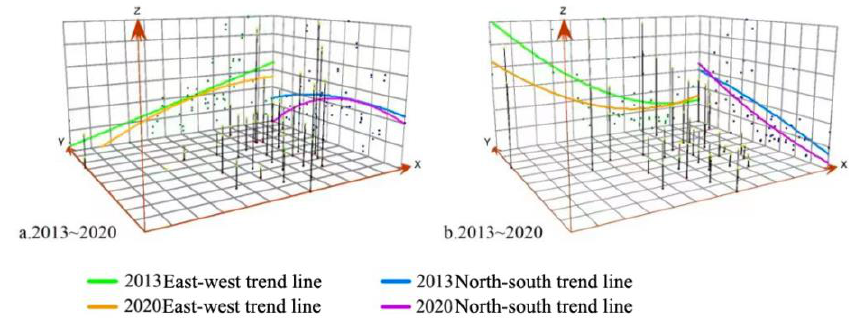
Figure 3. Analysis of the spatial trend of digital finance and green development.